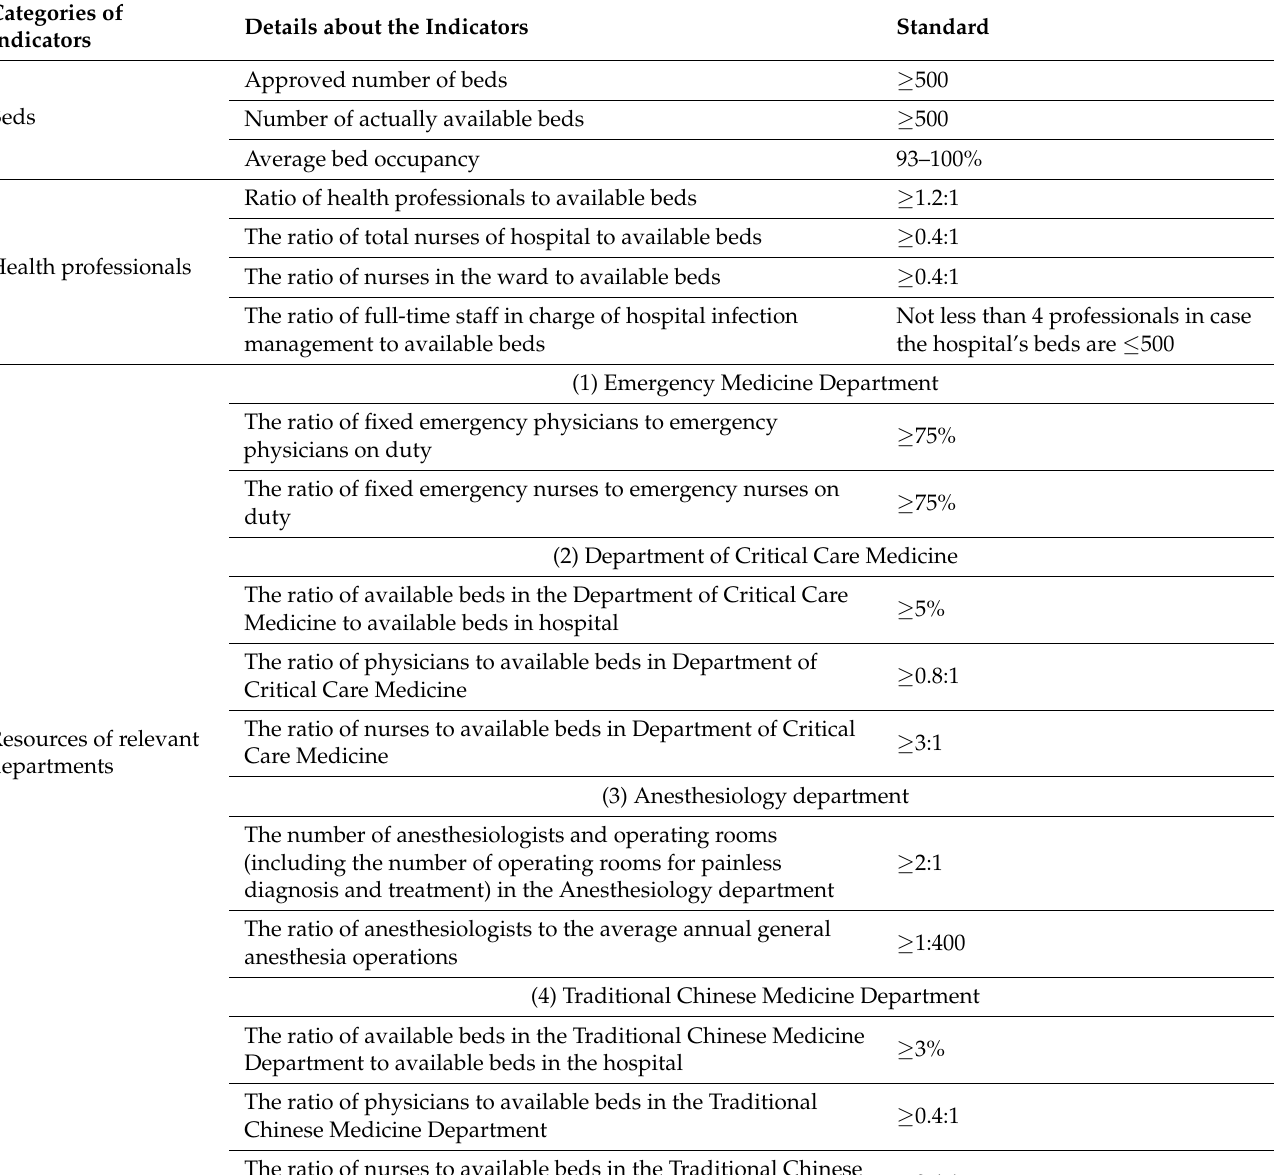
Table A1. Evaluation standard for tertiary